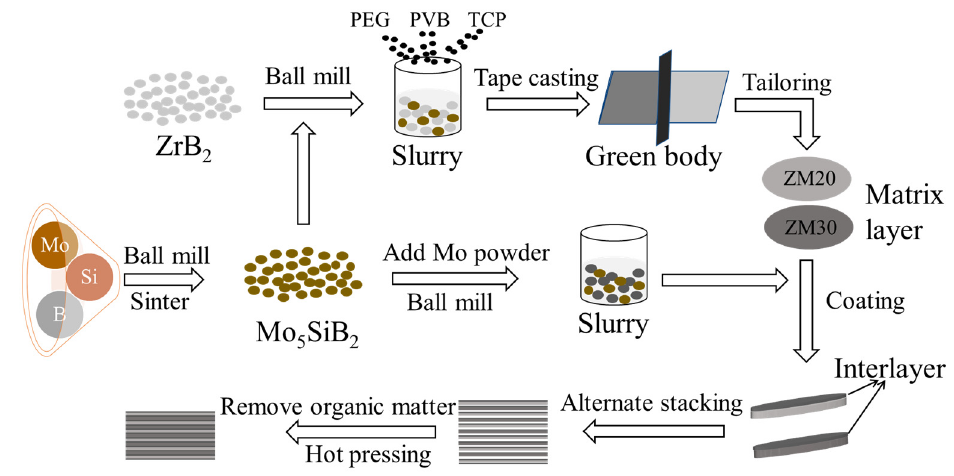
Figure 2. Flow chart for fabrication of the laminated ceramics.